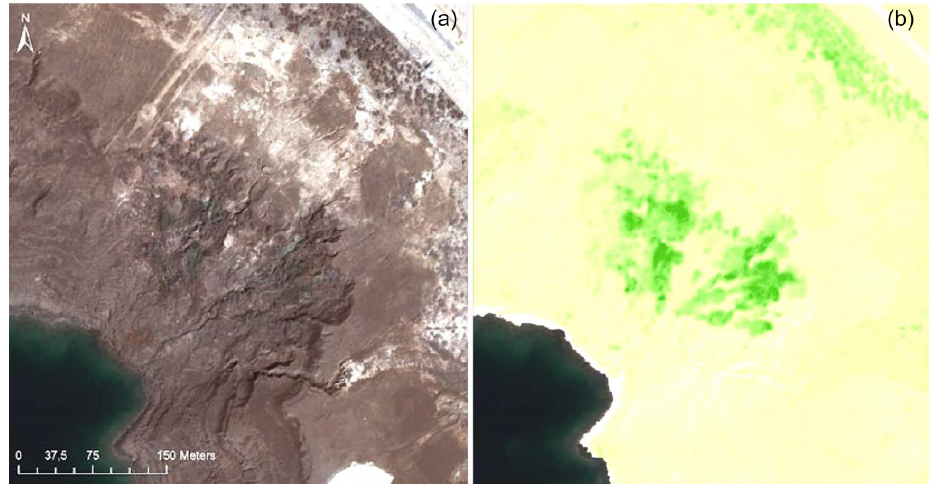
Figure 6. Comparison between optical and NDVI images over a landslide area. (a) Optical image (RGB) showing a seepage area. The muddy sediments impregnated with water and salt (white patches) flowed towards the lake and created an amphitheatre. (b) Evidence of the vegetation (green) that develops only near the